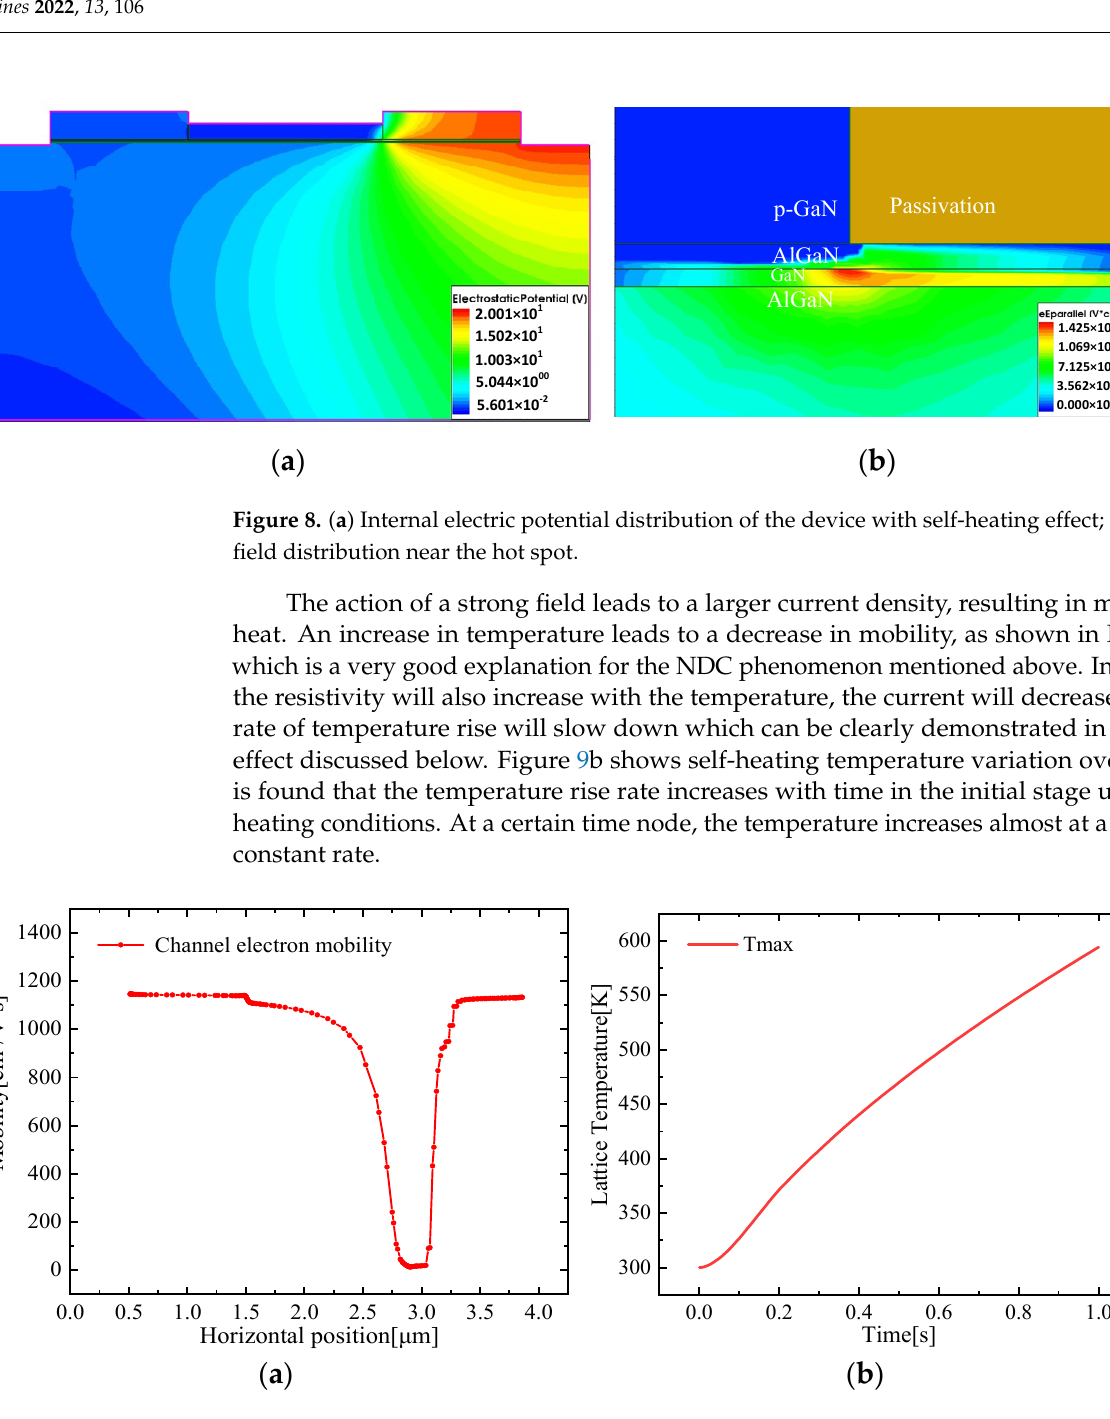
Figure 7. ( a ) Internal thermal distribution of the device under self-heating effect; ( b ) thermal distri- bution near the hot spot.